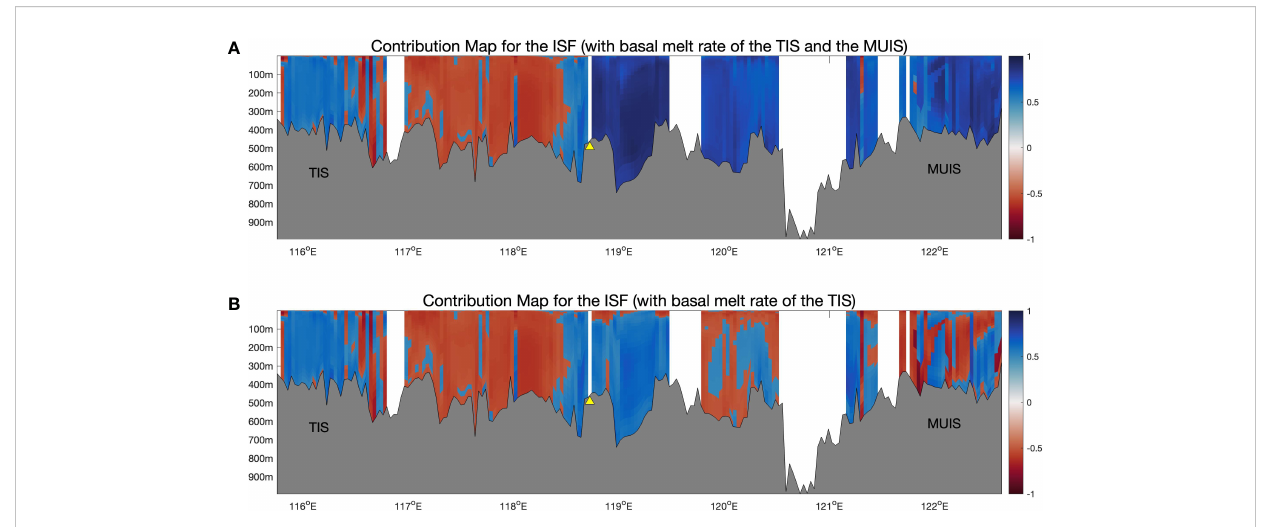
FIGURE 7 Depth pro fi les of C eddy (or C tide ) along the ISF transect, grey regions mark the sea fl oor topography. Top (A) , the estimated contributions from eddies (in red) and tides (in blue) calculated from the WTC between the heat transport at each grid cell and the basal melt rate of TIS (to the west of the yellow triangle area) and the basal melt rate of the MUIS (to the east of the yellow triangle area). Bottom (B) , is calculated from the WTC between the heat transport at each grid cell and the basal melt rate of TIS for the whole transect. Figure used cmocean (Thyng et al.,